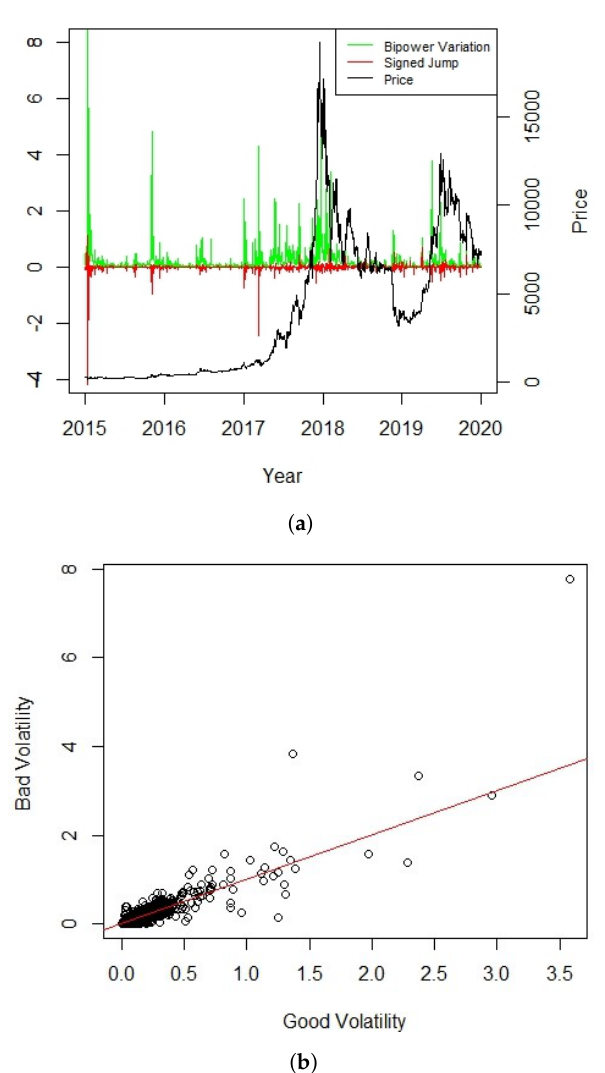
Figure 1. Bipower Variation (BV) and Signed Jumps, Good and Bad Volatility. ( a ) BV, signed jumps and the price of Bitcoin. The graph illustrates the continuous component of volatility (BV) and signed jumps on the left axis. The signed jump component is the difference between Good Volatility ( RS + ) and Bad Volatility ( RS − ). On the right axis, price of Bitcoin is illustrated. ( b ) Scatter Plot of Good Volatility ( RS + ) and Bad Volatility ( RS − ). The red line is the 45 degree line ( y = x